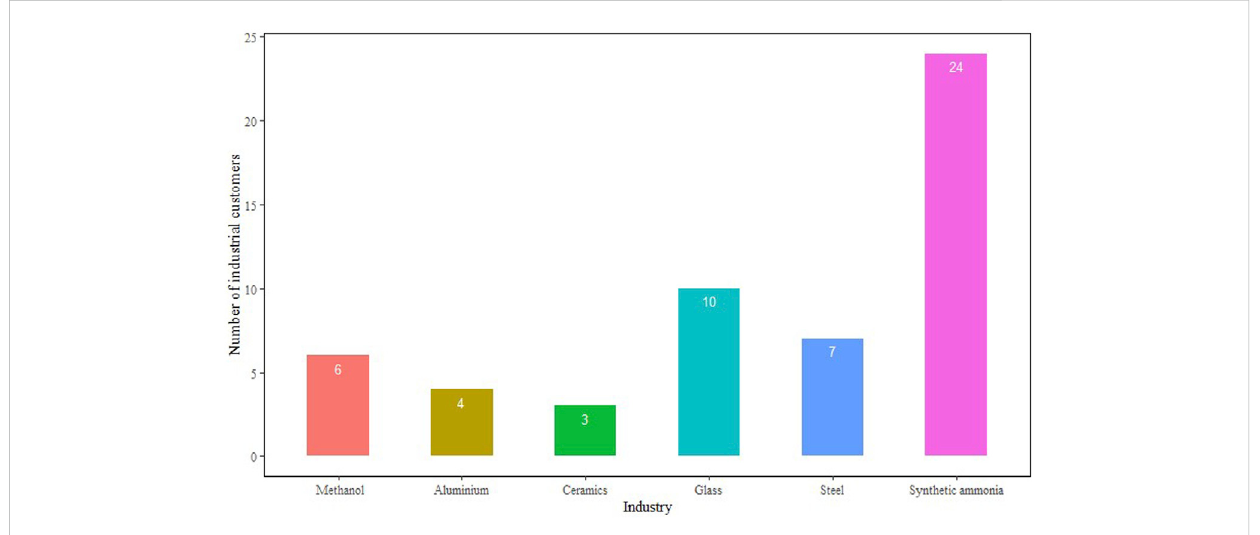
FIGURE 9 Number of natural gas customers by industrial categories.